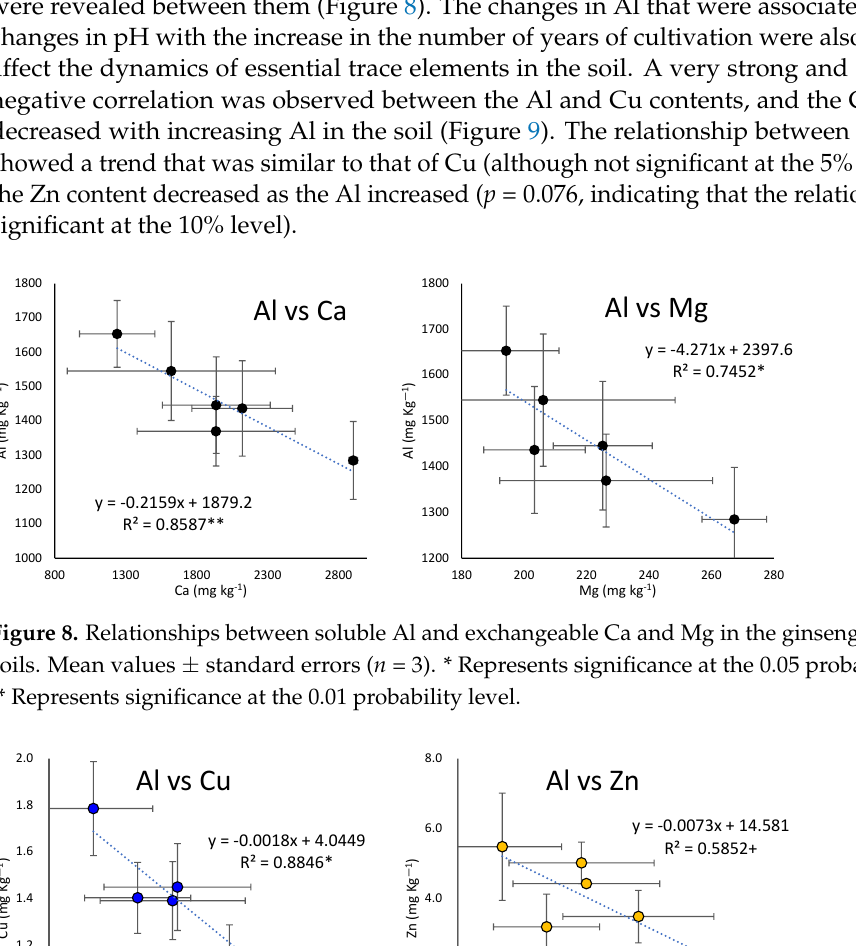
Figure 9. Relationships between soluble Al and exchangeable Ca and Mg in the ginseng cultivation soils. Mean values ± standard errors ( n = 3). + Represents significance at the 0.10 probability level. * Represents significance at the 0.05 probability level.